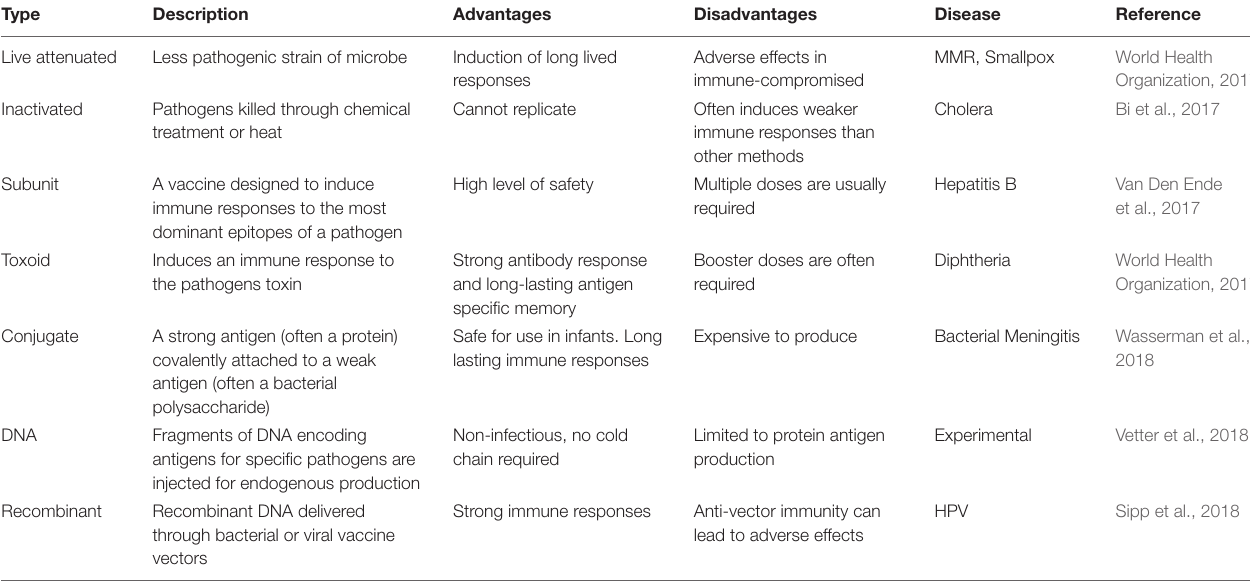
TABLE 1 | Vaccine types and